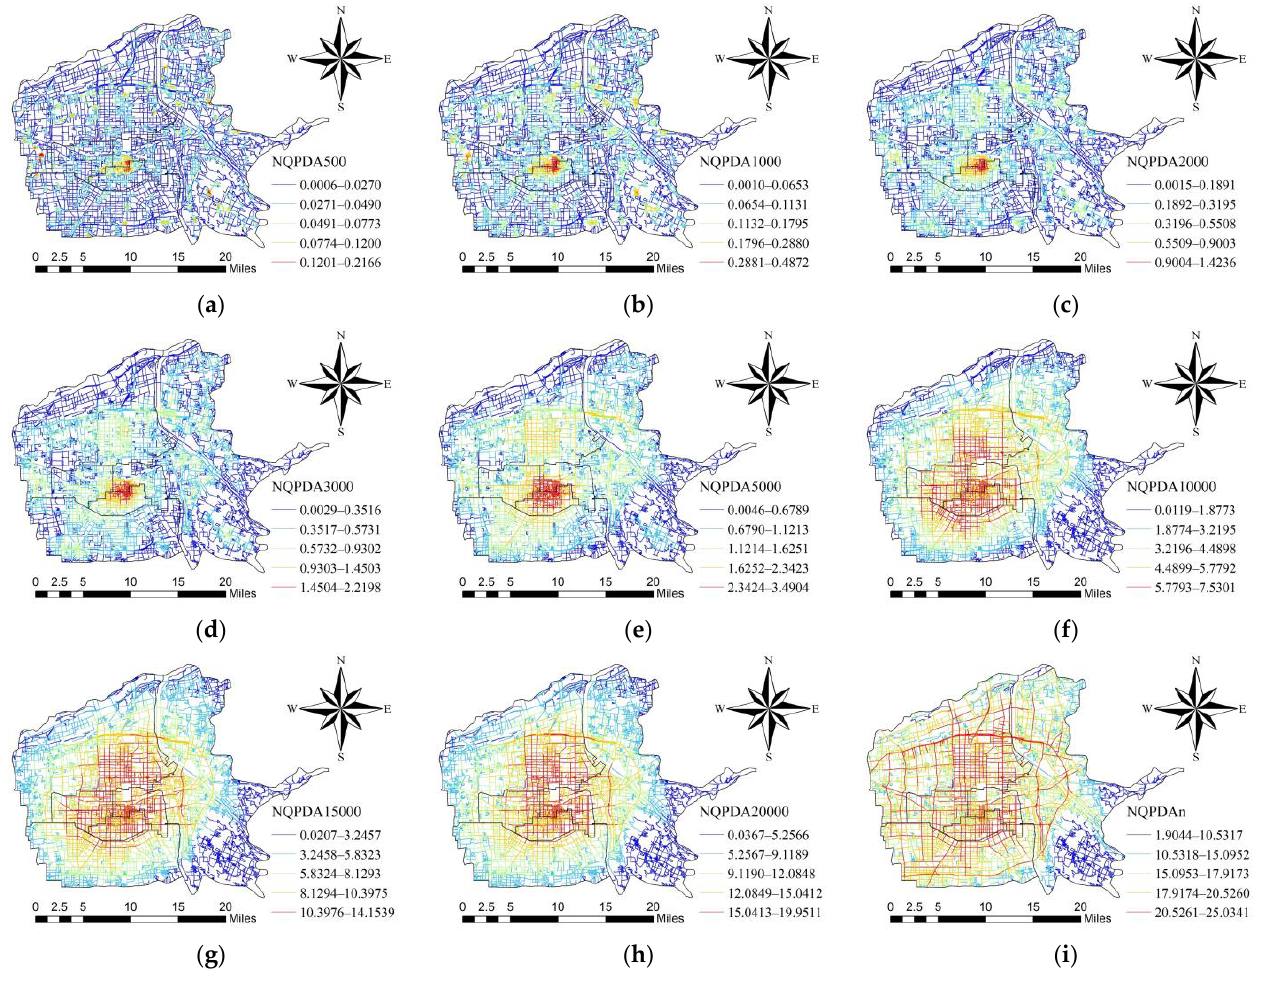
Figure 4. The closeness of the road networks at different scales in the main urban area of Xi’an (R denotes search radius). ( a ) R = 500 m; ( b ) R = 1000 m; ( c ) R = 2000 m; ( d ) R = 3000 m; ( e ) R = 5000 m; ( f ) R = 10,000 m; ( g ) R = 15,000 m; ( h ) R = 20,000 m; ( i ) R = n.